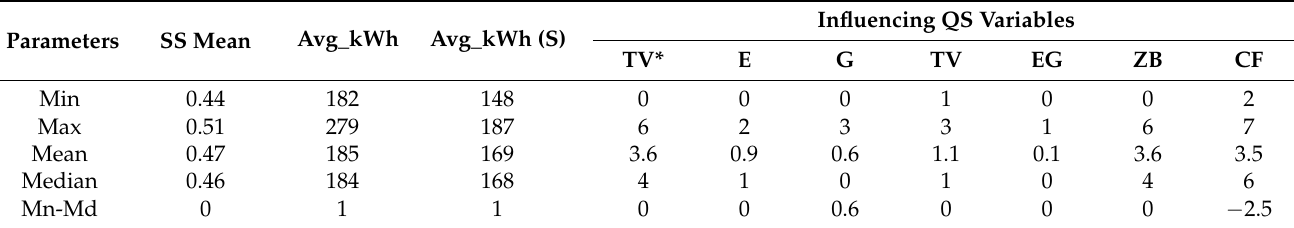
Table 9. 2nd-stage SOM + KM with clustering analysis of C1.